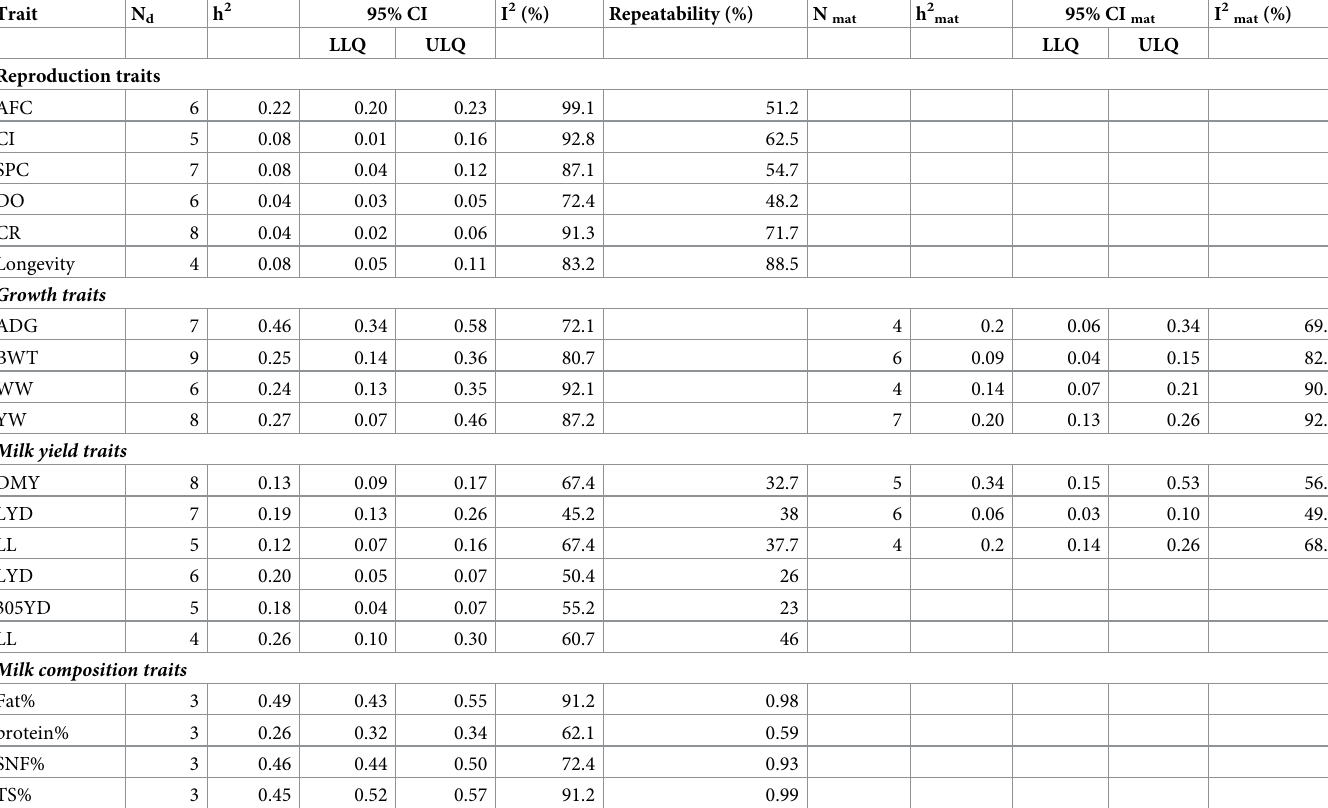
Table 5. Number of articles to estimate direct and maternal heritability (N d and N mat respectively), direct and maternal heritability (h 2 and h 2 mat respectively) estimated from meta-analysis using random-effects model, 95% confidence interval for heritability (95% CI and 95%CI mat respectively) and the I 2 index to test het- erogeneity in each trait (I 2 and I 2 mat